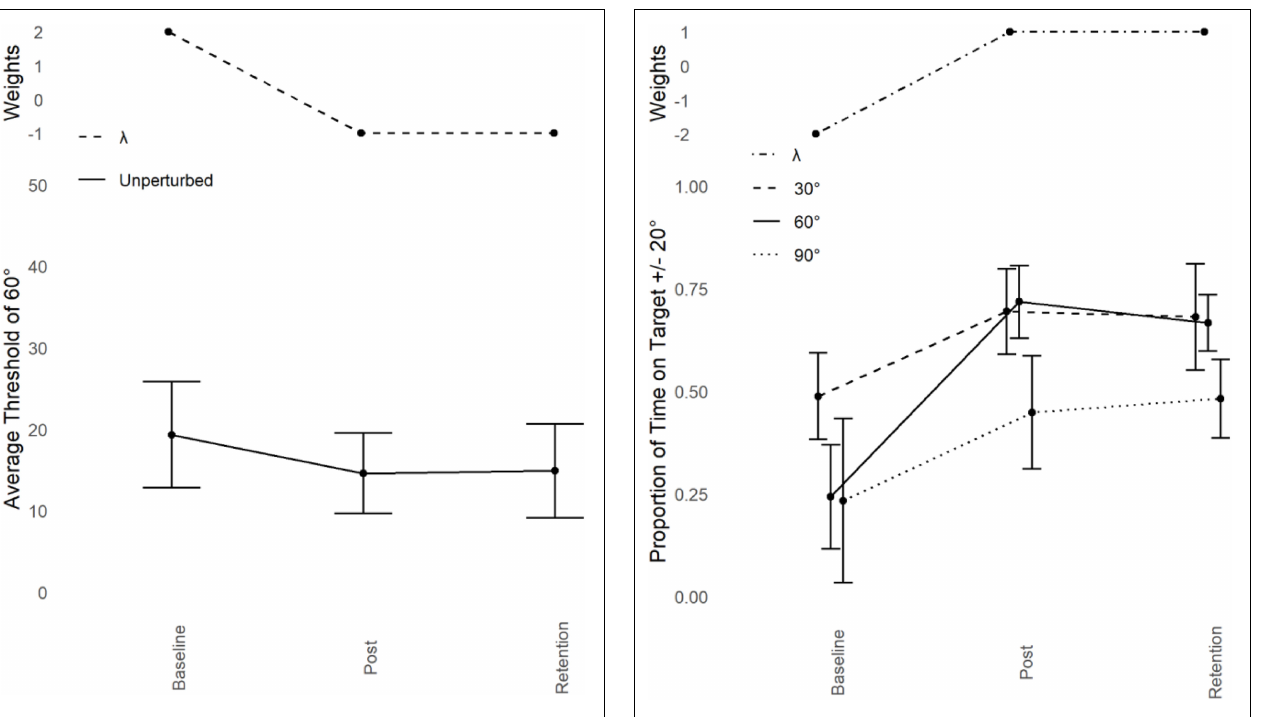
FIGURE 4 | Young adults trained at 60 ◦ : Performance transfer. Average performance data (Proportion of Time on Target ± 20 ◦ , lower) with standard error bars (lower) for the trained phase of 60 ◦ and transfer partners 30 ◦ and 90 ◦ in the three assessment sessions (Baseline, Post Training, and Retention) with corresponding Lambda ( λ ) weights